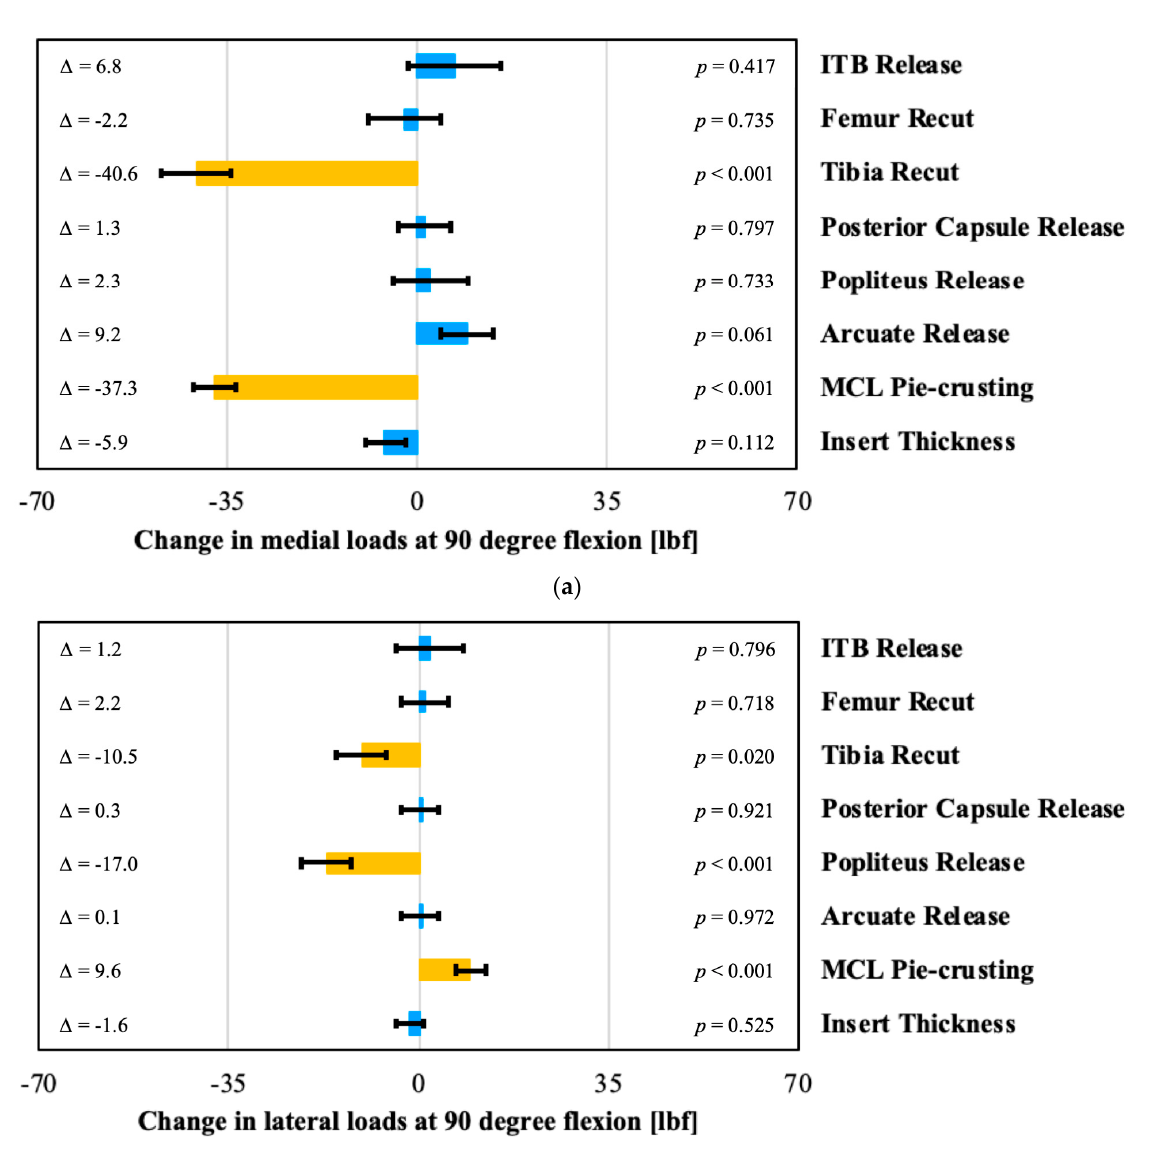
Figure 5. Evaluation of the effect of surgical correction on ( a ) medial ( b ) and lateral loads in 90 degrees of flexion, with orange bars indicating statistically significant effects. Each change is the post-correction value minus the pre-correction value.